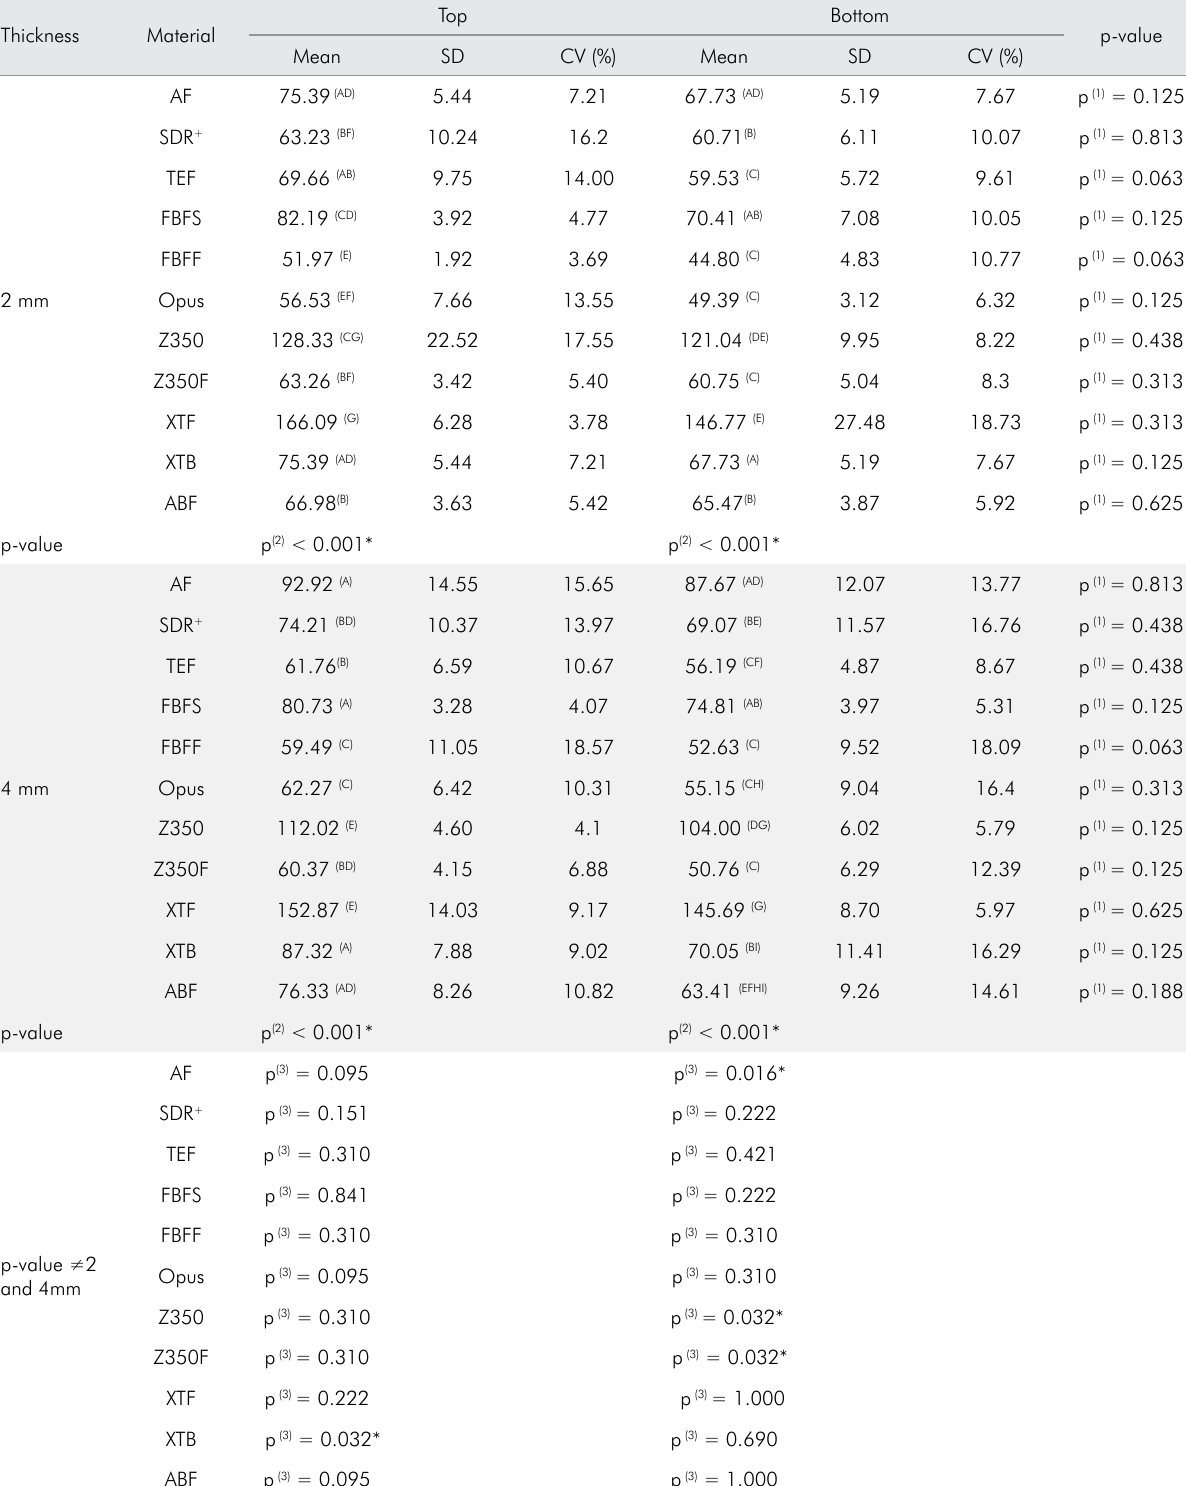
Table 6. Mean ± standard deviation of microhardness according to material, thickness, and surface of the test specimen subjected to